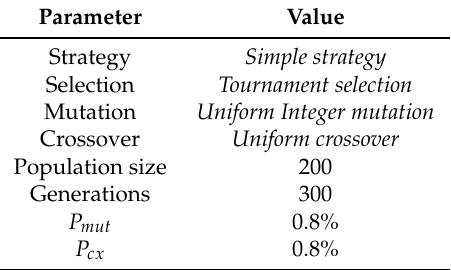
Table 2. Default genetic algorithm (GA)